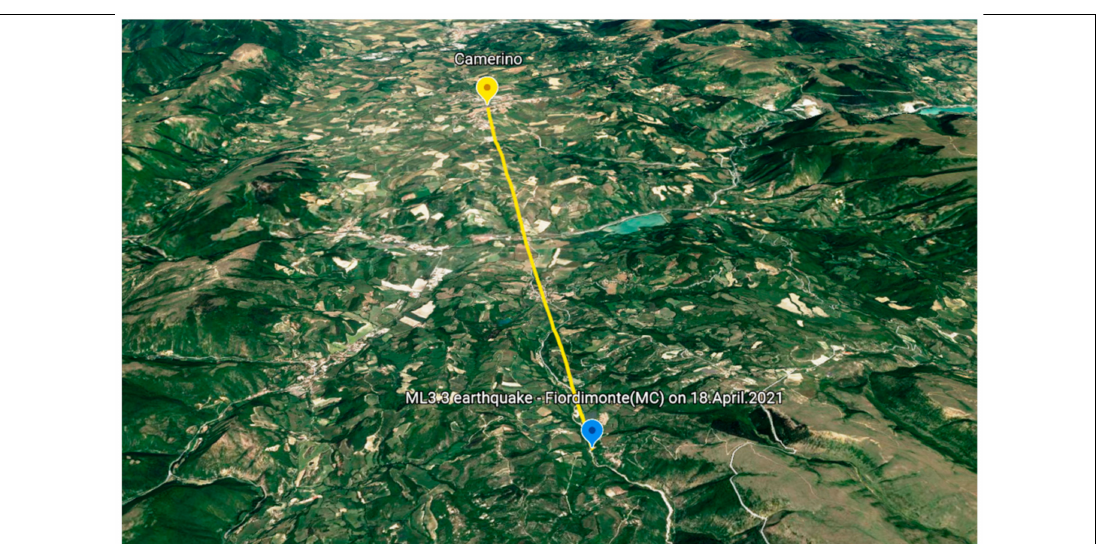
Figure 5. ML3.3. The earthquake occurred at Fiordimonte (Italy) on 18 April 2021 and epicentral distance from Camerino (basemap powered by Google Earth